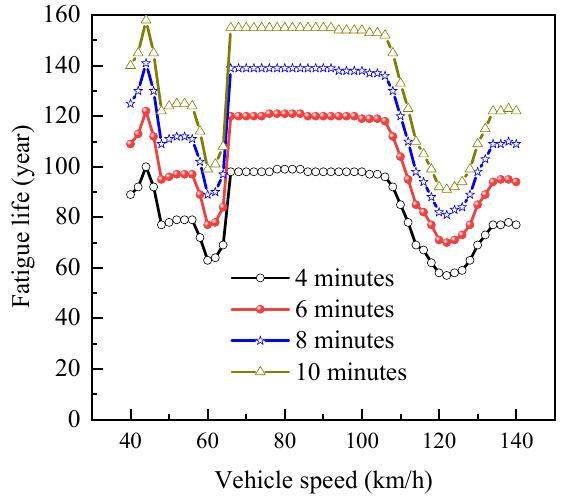
Figure 12. Fatigue of 25 m-span bridge under various vehicle speed.